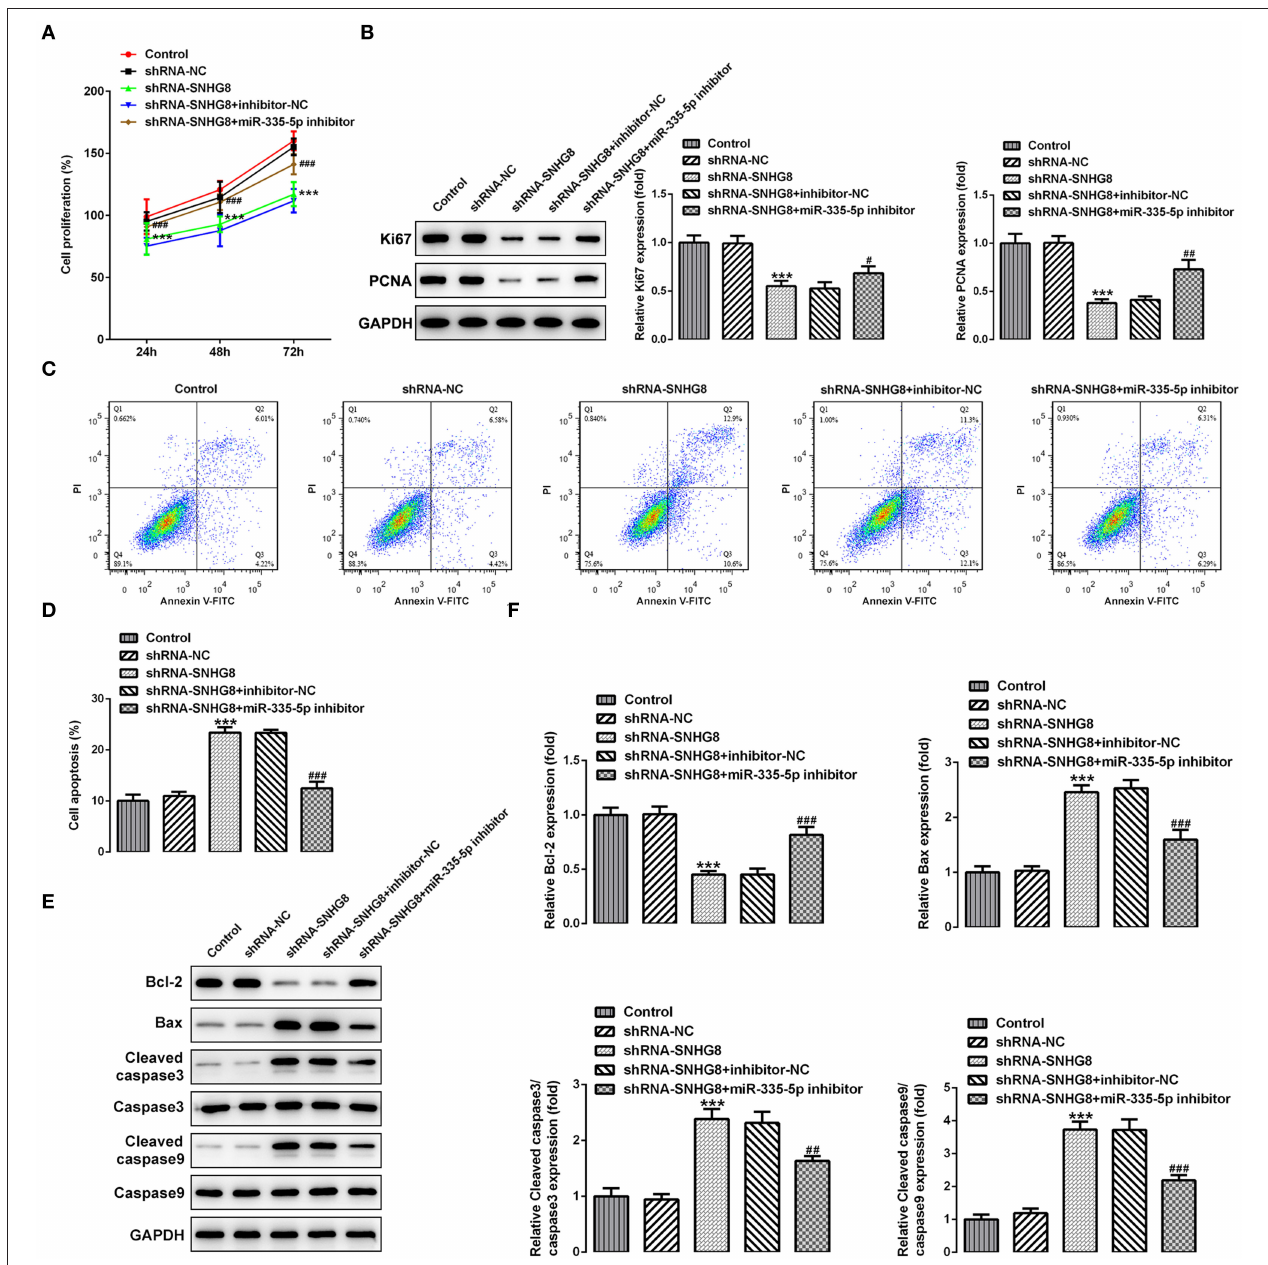
FIGURE 5 | The inhibition of miR-335-5p blunts the effect of SNHG8 silence on DLBCL cell proliferation and apoptosis. (A) The proliferative rate of U2932 cells transfected with indicated vectors was detected by the CCK-8 assay. (B) The protein expression of Ki67 and PCNA in U2932 cells was detected by Western blotting assay. (C,D) The apoptotic rate of U2932 cells transfected with indicated vectors was measured by flow cytometry. (E,F) The expression of proteins involved in cell apoptosis in U2932 cells transfected with indicated vectors was measured by Western blotting assay. *** p < 0.001 vs. shRNA-NC. # p < 0.05, ## p < 0.01,